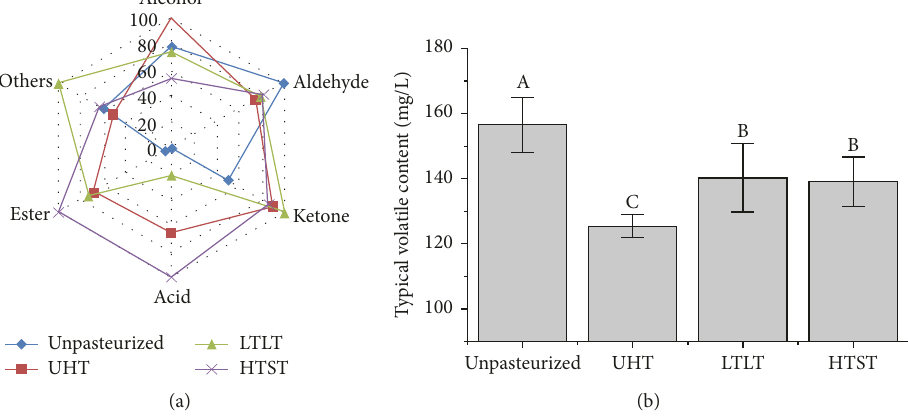
Figure 5: Effect of treatments on the distribution of the volatile chemical structure (a) and the content of the typical volatiles (b) and of the watermelon juice. UHT: ultrahigh temperature; LTLT: low temperature long time; HTST: high temperature short